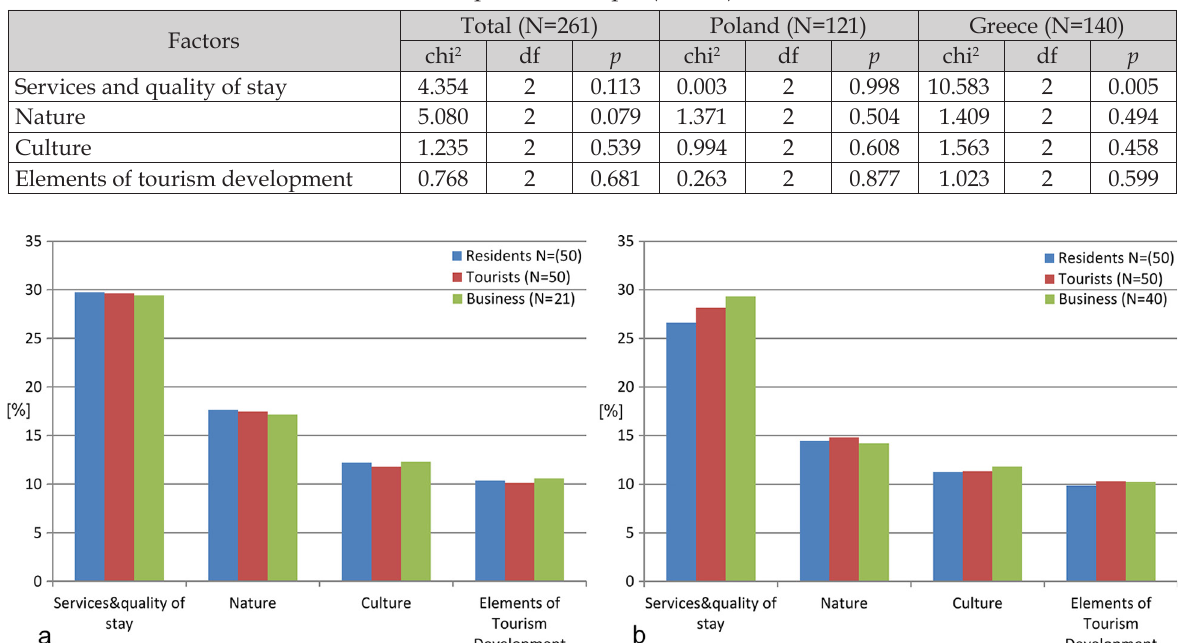
Fig. 7. A comparison of average assessments of landscape elements, by respondent group, for the cohort of Polish (a) and Greek (b)